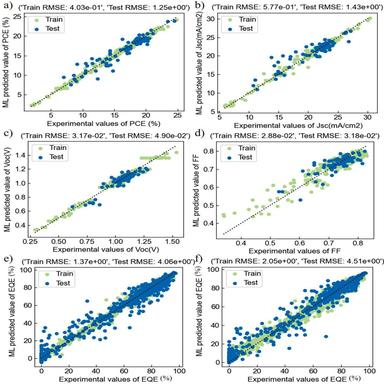
The score of predictive models. Where the X-axis is the experimental values recorded in the publication and the Y-axis is the predicted values obtained by the predictive model. The training set is used to evaluate the training of the model and the test set is used to evaluate the generalisation ability of the model. a) Evaluation of the model PCE:XGBoost, b) Evaluation of the model Jsc:XGBoost, c) Evaluation of the model Voc: XGBoost, d) Evaluation of the model FF:XGBoost, e) Evaluation of the model EQE:XGB